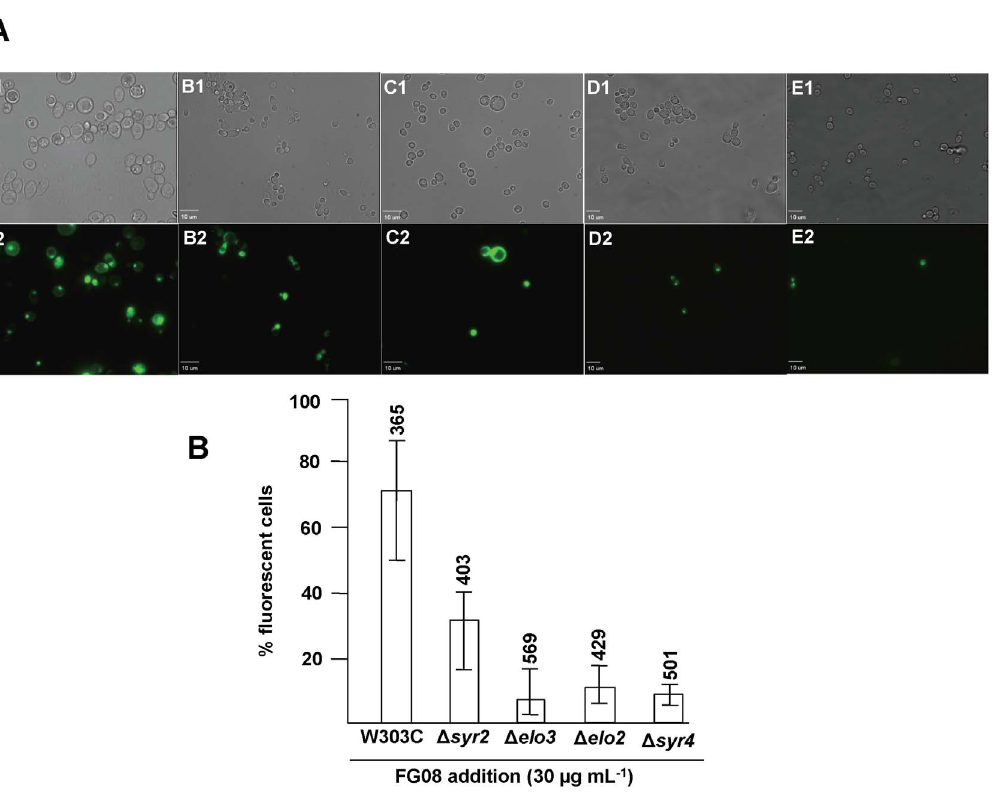
Figure 3. Effect of FG08 on SYTOX Green dye staining of S.cerevisiae strain W303C and isogenic sphingolipid biosynthetic mutants. Strain W303C (A1, A2), and isogenic mutants W303- D syr2 ( sur2 ) (B1, B2), W303- D e lo3 (C1, C2), W303- D e lo2 (D1, D2) and W303- D syr4 ( ipt1 ) (E1, E2) were exposed to FG08 (30 m g mL 2 1 ) for 10 min. A) Each cell observed in bright-field mode (A1–E1) was also observed for fluorescence (A2–E2). B) The % fluorescent cells in each microscopic field that stained with SYTOX Green were calculated. The range bars show variations in % fluorescent cells from analyses of 10 separate microscopic image fields randomly selected from at least two separate experiments. The numbers above the range bars indicate the total number of cells analyzed. Untreated yeast cells showed less than 3% staining. Distance bar length shows 10 m m.